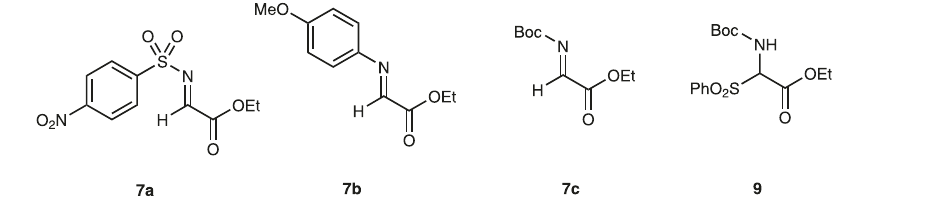
Fig. 4 | Imines and the precursor of imine. In this work, 7a - 7c , and 9 were investigated. Boc t -butoxycarbonyl, Me methyl.